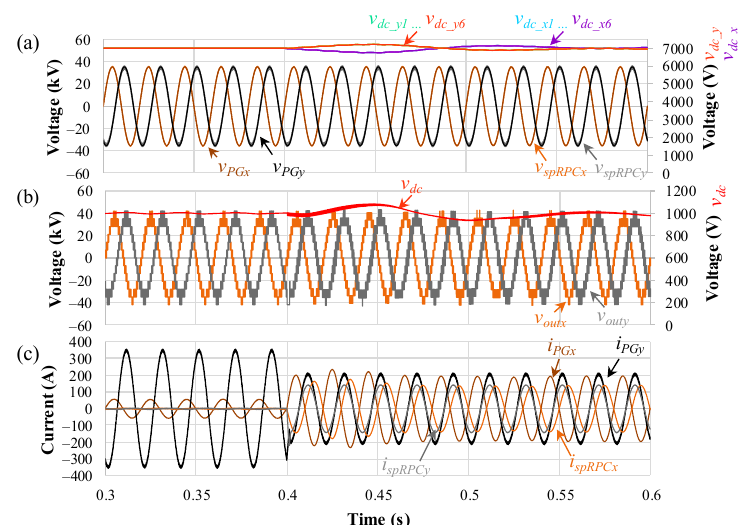
Figure 14. Detailed real-scale simulation results during the time interval from 0.3 s to 0.6 s: ( a ) the voltages on each TPS, v PGx and v PGy , the output voltages of the sp RPCx and sp RPCy , v spRPCx and v spRPCy , and voltages on the dc-link of each submodule, v dc_x1 to v dc_x6 , and v dc_y1 to v dc_y6 ; ( b ) the multilevel voltage of the spRPCx and spRPCy , v outx and v outy , and the voltage of the common dc-link voltage, v dc ; ( c ) the currents on each TPS, i PGx and i PGy , and the output currents of the sp-RPC, i spRPCx and i spRPCy .